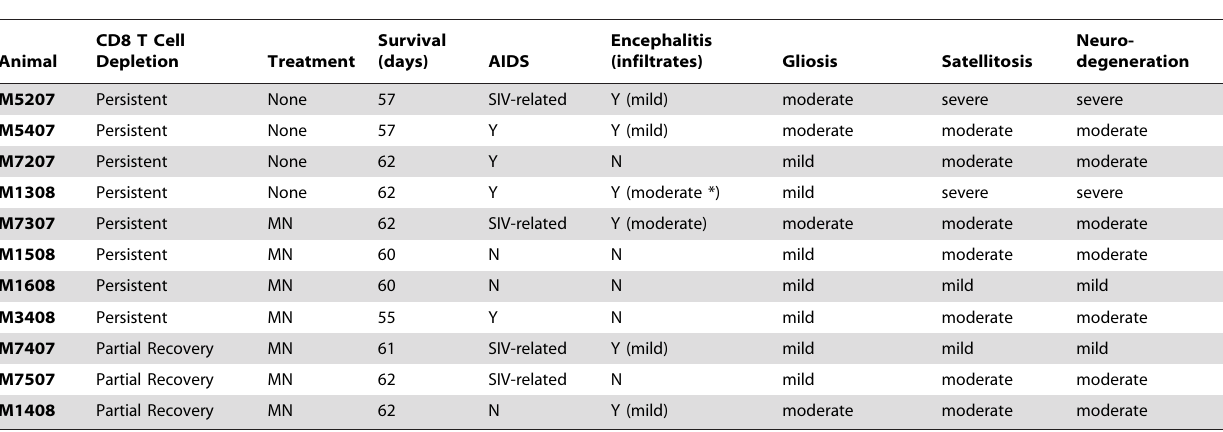
MNGCs: multinucleated giant cells. * rare MNGCs. Objective scoring: Five regions within the H&E section of frontal cortex were examined and scored at 10 6 magnification using the following criteria for encephalitis, satellitosis, and neurodegeneration. Gliosis scoring was performed on 5–8 H&E brain sections. Encephalitis scoring: Mild- perivascular infiltrated in one brain region; Moderate- perivascular infiltrates in two or more regions plus rare MNGCs; Severe-perivascular infiltrates in all regions and frequent MNGCs. Gliosis scoring: Mild- increased cellularity in white matter in one brain region; Moderate- increased cellularity in white matter in two or three regions plus occasional microglial nodules; Severe- increased cellularity in white matter in all regions with frequent microglial nodules. Satellitosis scoring: Neurons surrounded by 3 or more glial cells are characterized as mild (occasionally occurring); moderate (frequently) and severe (numerous, in addition to clusters of 3 or more glial cells at sites of neuronal drop-out). Neurodegeneration scoring: Mild- occasional angular, shrunken neurons; Moderate- frequent angular, shrunken neurons; Severe- numerous angular, shrunken neurons and neuronal drop-out.